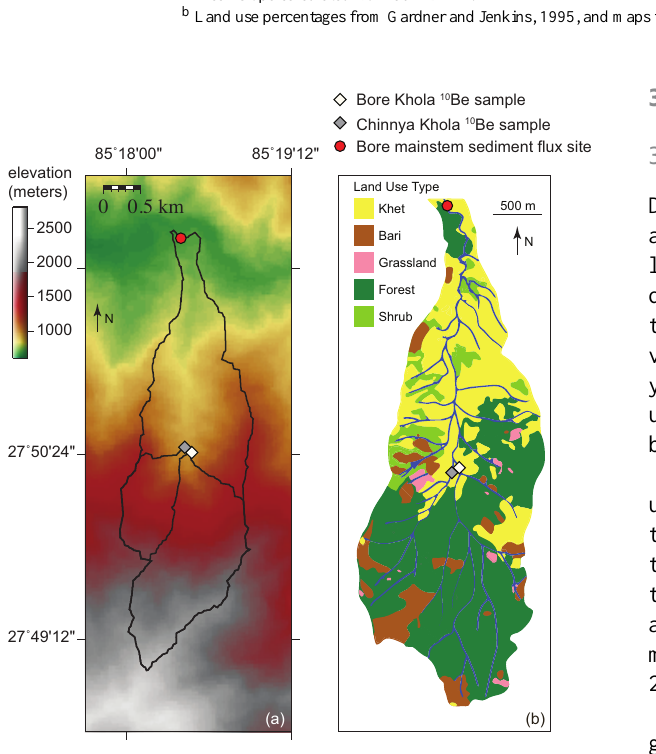
Figure 3. Detailed maps of elevation (a) and land use (b) of the Bore Khola subcatchment of the Likhu Khola. The Bore Khole includes the Bore and Chinnya headwater catchments that were sampled for determining long-term denudation rates from 10 Be qtz . Note that these low-order, headwater catchments are predominantly forested with little agricultural land use, so they are expected to provide a robust background erosion rate. Land use map is adapted from Gerrard and Gardner (1999), with unknown projection that does not exactly match panel (a) . Bari are rainfed terraces; khet are irrigated terraces (see